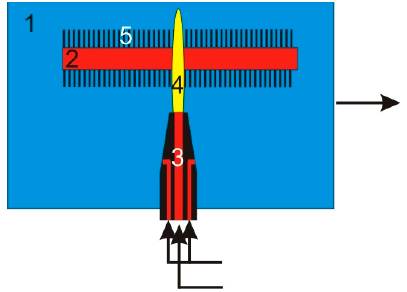
Figure 2. The general setup of the microwave plasma reactor where: 1—reaction chamber; 2—substrate with catalyst layer; 3—plasma nozzle; 4—plasma; 5—carbon nanotubes.